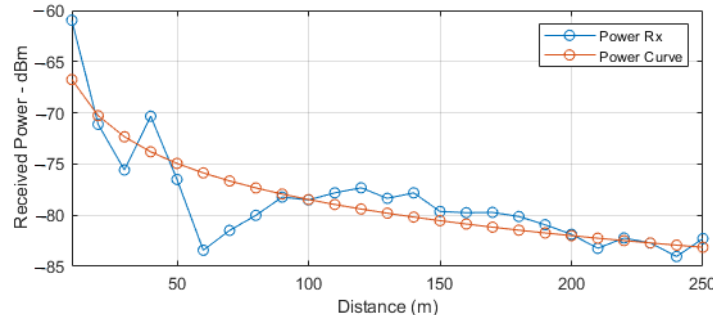
Figure 7. Receiver power over distance.